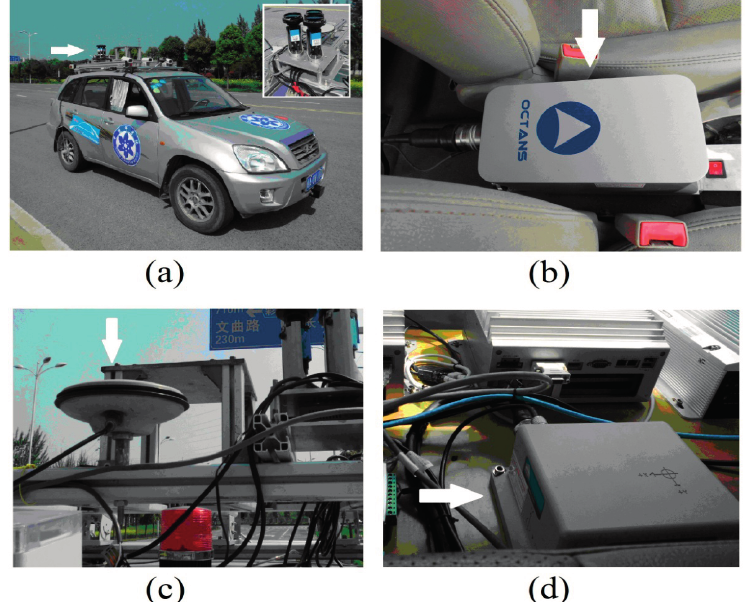
Figure 7. The experimental